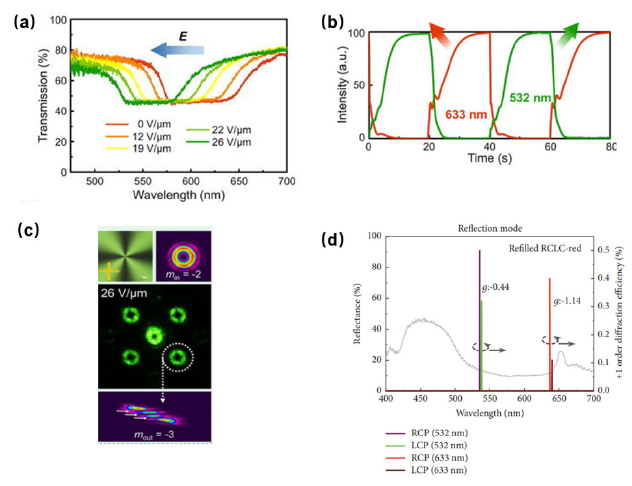
Figure 8. ( a ) Dependency of the PBG shift on applied voltage in the tunable bandpass OV array generator; ( b ) the responsiveness of the tunable bandpass OV array generator; ( c ) POM micrographs of q ‐ plate and the intensity distribution of generated OVs; reprinted with permission from Ref. [86].